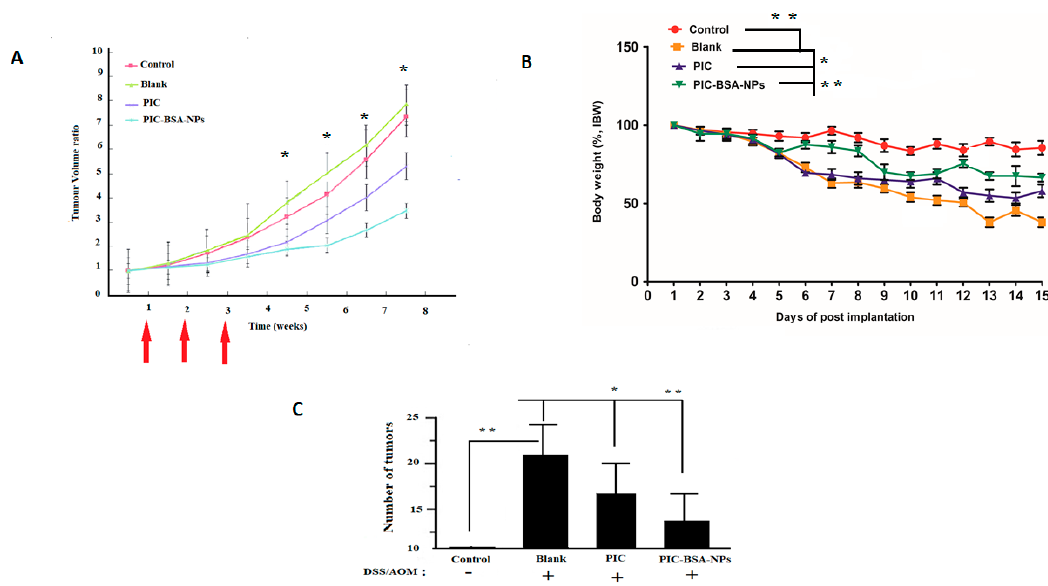
Figure 8. E ff ect of PIC-loaded albumin nanoparticles on tumor size, number of tumors, and body weight. The e ff ect of PIC-loaded albumin NPs and free PIC on azoxymethane / dextran sodium sulphate-induced colon carcinogenesis ( n = 10 per group). ( A ) The size of the tumor reduced significantly ( p < 0.05) in the PIC–BSA NP group compared to the control (negative or blank). ( B ) Percentage body weight reduction was significant ( p < 0.05) in PIC–BSA NPs. ( C ) Number of tumors reduced very significantly ( p < 0.05) in PIC–BSA NPs compared to control, blank, and free PIC, respectively.